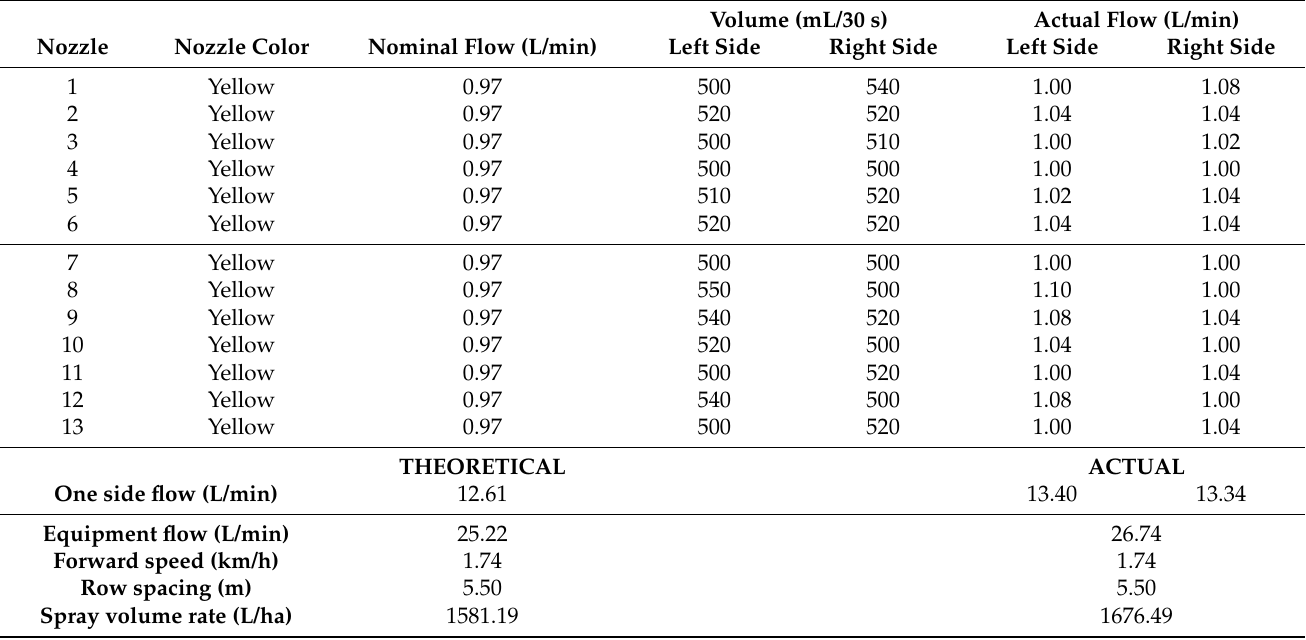
Table A10. Selection and calibration of nozzles for the C2 sprayer, with the following configuration: No adjusted to the vegetation/High & Low fan speed/Low spray volume rate/Conventional nozzles (Fine)/Pressure: 9